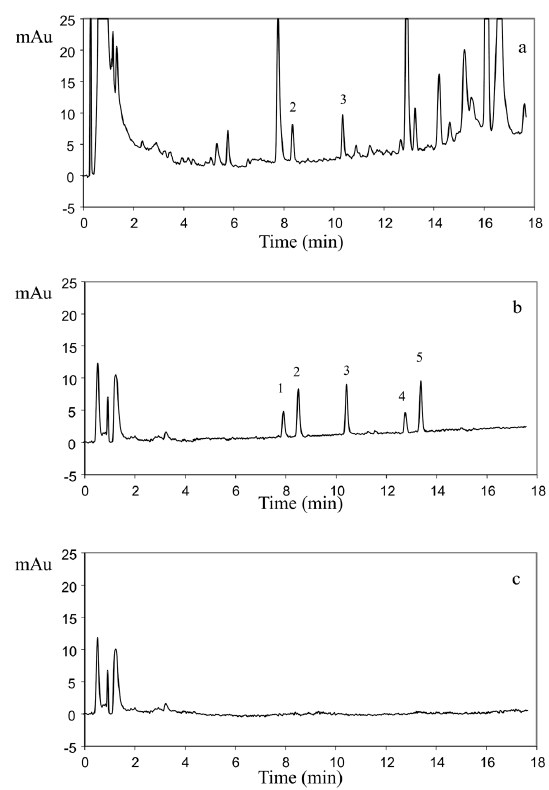
Figure 4. Comparison of chromatograms obtained in the analysis of soil samples from Albufera: ( a ) Spiked crude soil sample extract (10 ng g − 1 ); ( b ) Spiked soil sample extract (10 ng g − 1 ) after performing HFM-protected-MI-MSPE; ( c ) non-spiked soil sample extract after performing HFM-protected-MI-MSPE. Peak assignment: 1. SIM; 2. CYA; 3. ATZ; 4. PPZ; 5. TER.